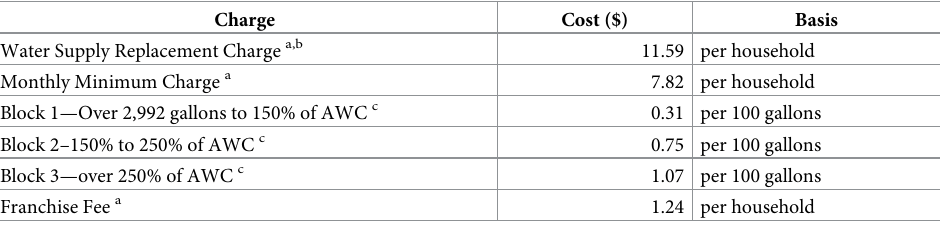
Table 2. El Paso Water residential monthly fixed and volumetric water charges for water in 2020 (Source https://